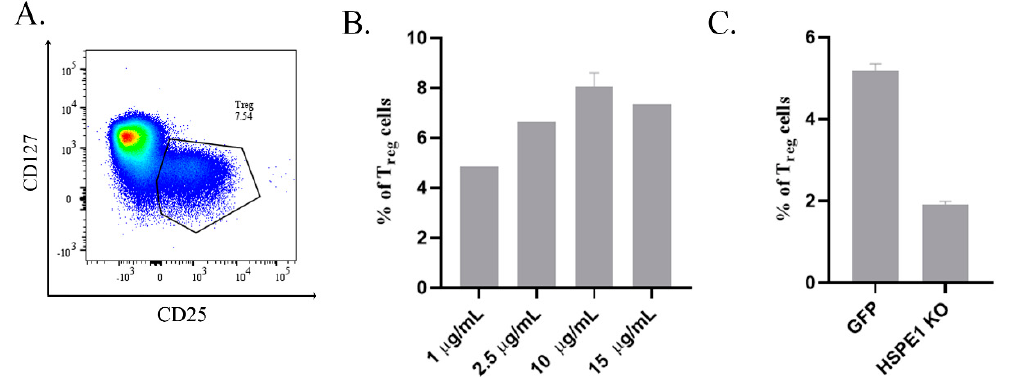
Figure 3. rHSPE1, BeWo GFP-iEV, and BeWo HSPE1 KO-iEV induced T reg di ff erentiation from CD4 +